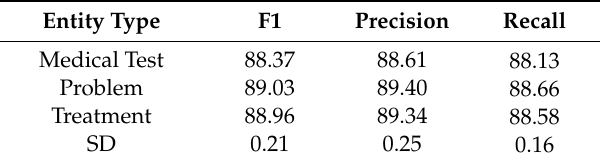
Table 4. Evaluation of each type of